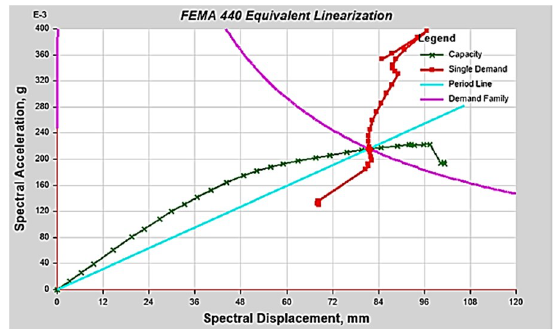
Figure 4. Nonlinear static analysis result (Type 1).